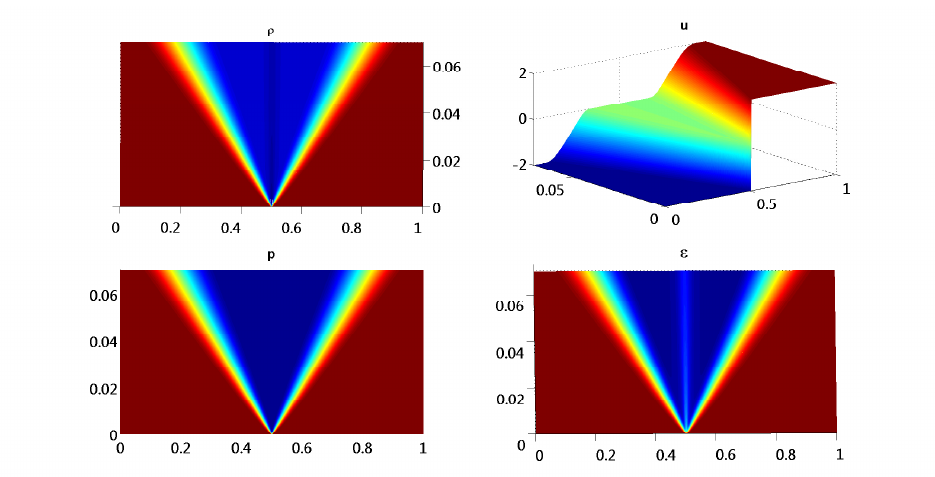
Figure 6. Test 3 (the stiffened gas): the space–time graphs.